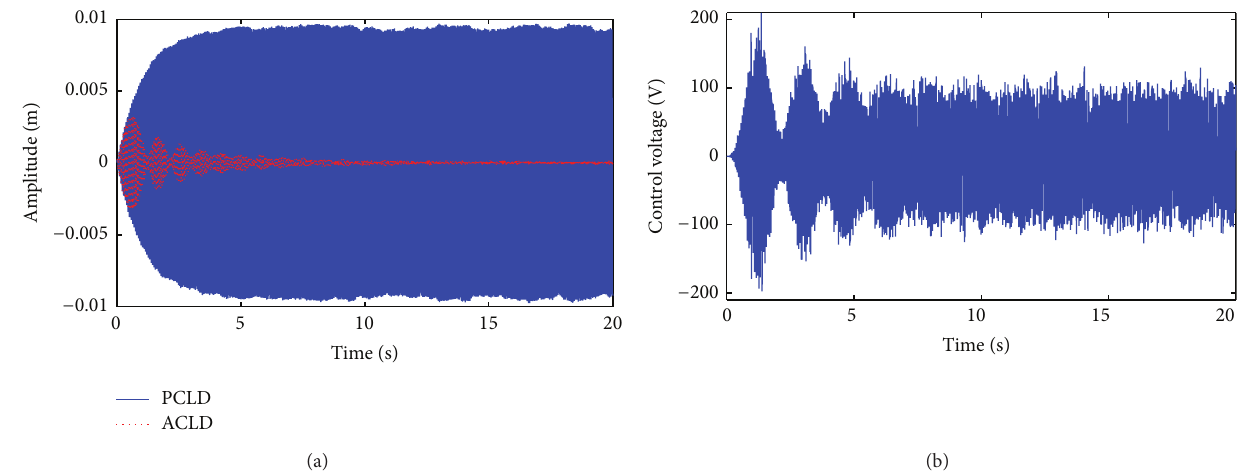
Figure 9: The displacement response for a mixed disturbance using the FxLMS feedforward controller: (a) the displacement response, (b) the control voltage.